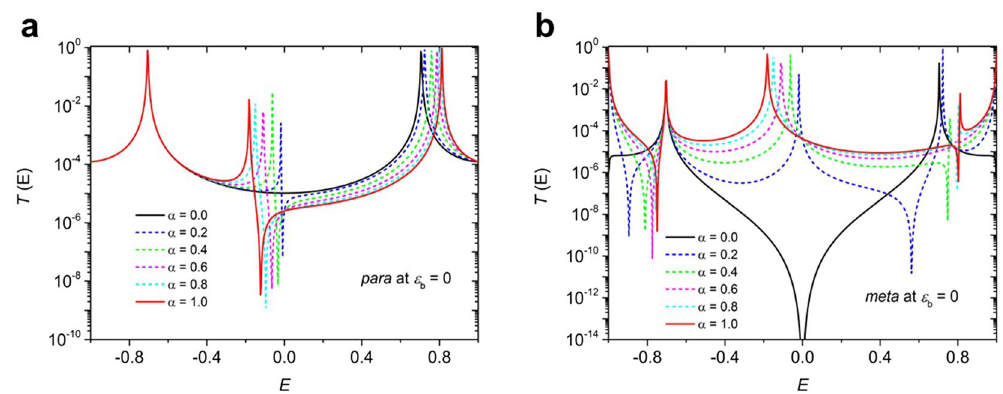
Figure 5. T (E) vs. E for different values of α at ε b = 0. Transmission coefficients T (E) for para -connection ( a ) and meta -connection ( b ), when ε b =